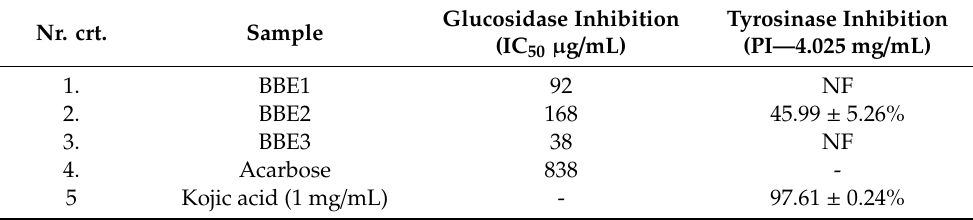
Table 9. Enzyme inhibitory e ff ects of beech bark